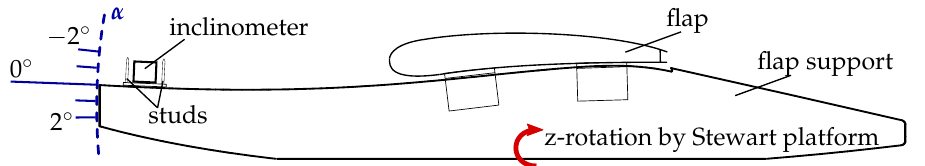
Figure 10. Experimental setup for inclination measurement of the flap by a rotation around z-axis.